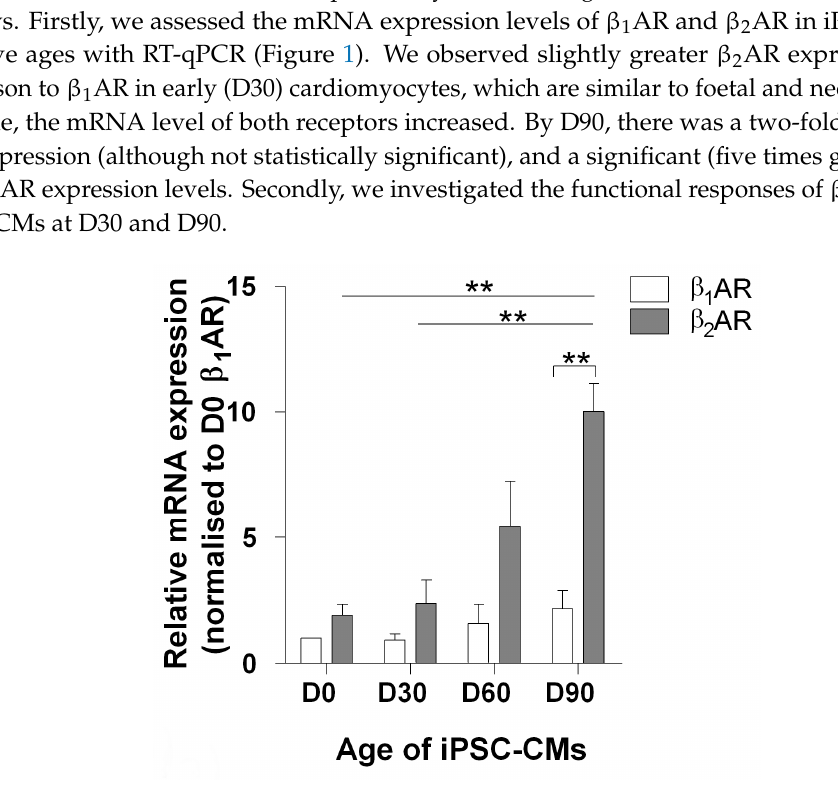
Figure 1. Stimulation of β AR with isoprenaline induces dose-dependent cAMP release. Differential ADRB1 and ADRB2 gene expression in iPSCs (D0) and iPSC-CMs after 30, 60, and 90 days of differentiation. n/N = 3/3; n/N = replicates/batches. Data shown as mean ± SEM, ** p < 0.01 between marked groups; β 2 AR D0 vs. β 2 AR D90, β 2 AR D30 vs. β 2 AR D90, and β 1 AR D90 vs. β 2 AR D90 (1-way ANOVA with Tukey’s post hoc